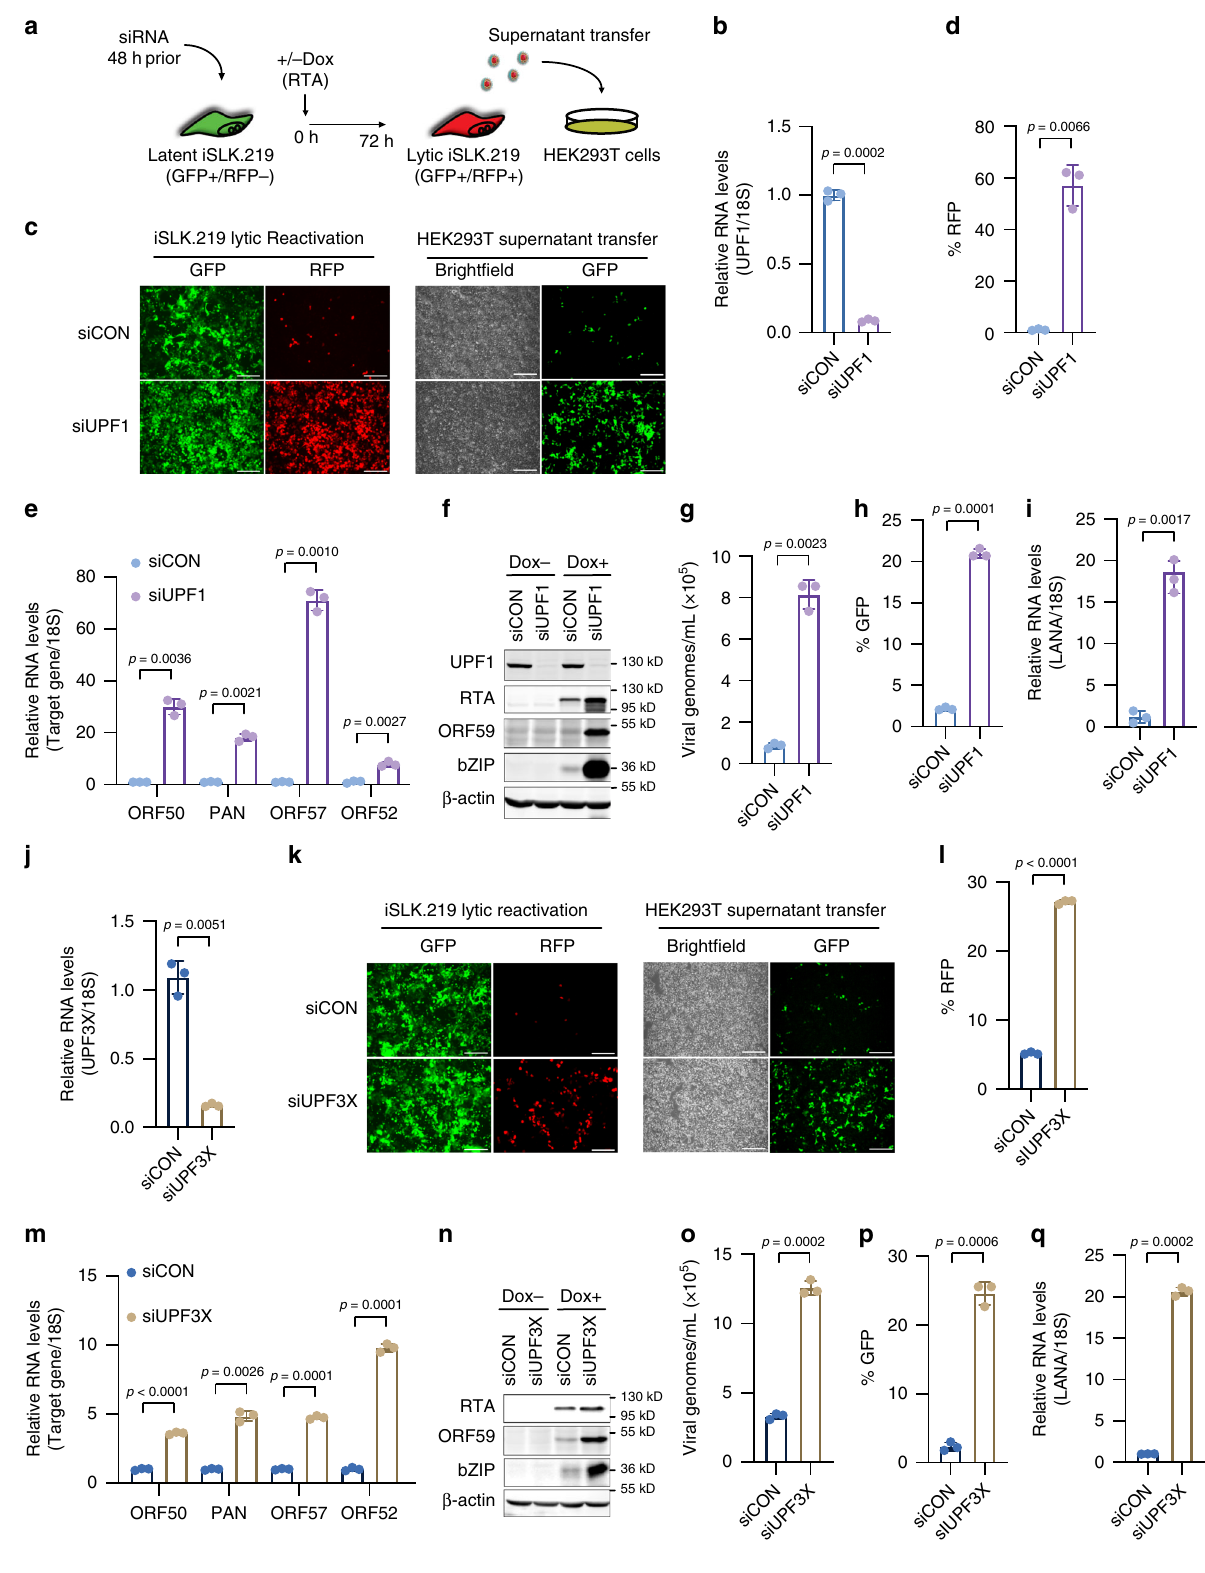
UPF1-siRNA (siUPF1) treated cells relative to control-siRNA (siCON) treated cells (Supplementary Fig. 2f). While the increase in spontaneous reactivation was minor, Dox-induced lytic reactivation was robustly enhanced in siUPF1- treated cells relative to siCON-treated cells (Fig. 2b, c).